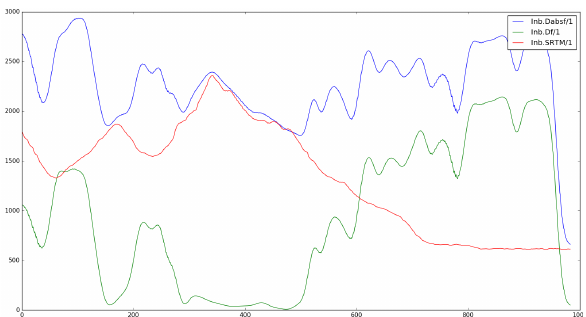
Figure 16. Profile test case Inb, green: cloud heights above ground, red: ground DEM (SRTM 1 arcsec), blue: absolute cloud heights EVALUATION For evaluation of the results we measure the distance of the cloud positions to the corresponding positions of the cloud shadow as shown in fig. 17. h c is the cloud height above ground which was derived using our described method. d is the mea- sured distance of a cloud-point with the corresponding shadow- point. H c and H s are the heights of the surface model on which the Sentinel-2 scene was orthorectified. s z is the sun zenith an- gle for the acquisition